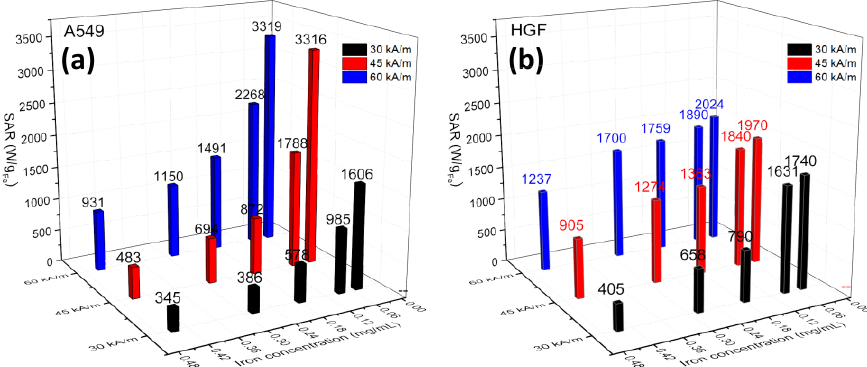
Figure 10. SAR dependence on the concentration of the internalized IOMNPs in ( a ) A549 and ( b ) HGF cells for each evaluating H values of 30, 45, and 60 kA/m.